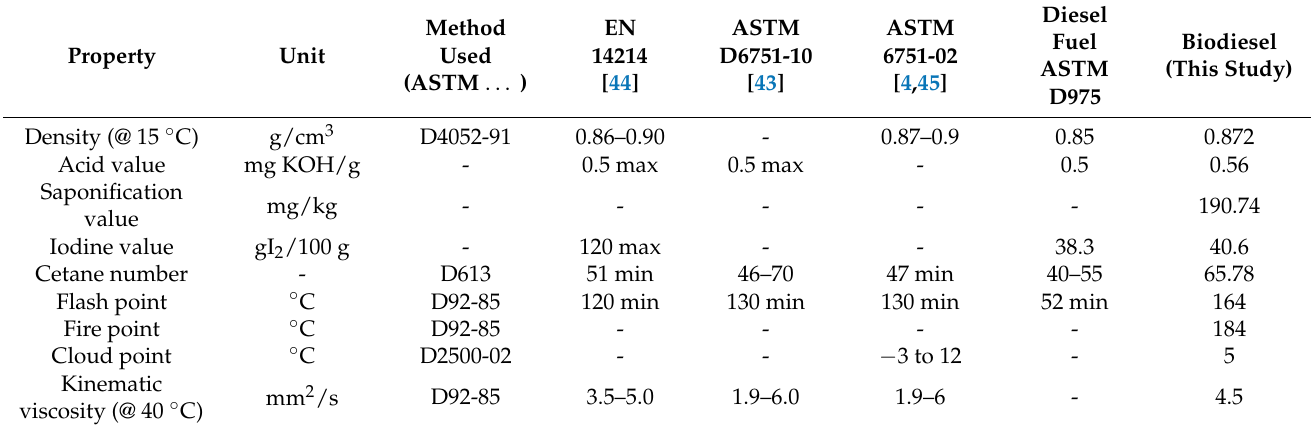
Table 6. Physiochemical properties of chicken feet oil biodiesel.